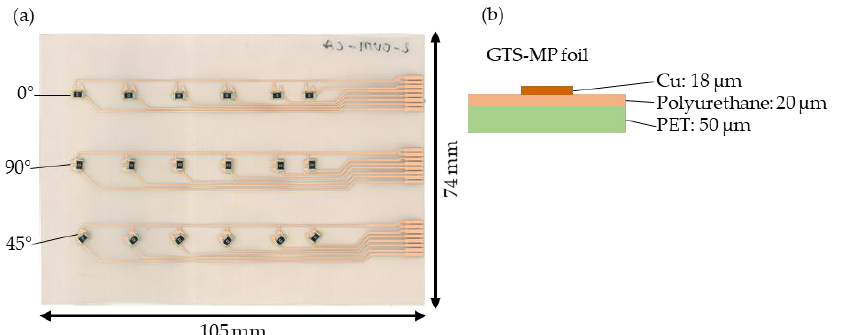
Figure 2. Assembled foil for overmolding (developed in [9]) using 1206 resistor components ( a ) and a layer structure of the foil ( b ).